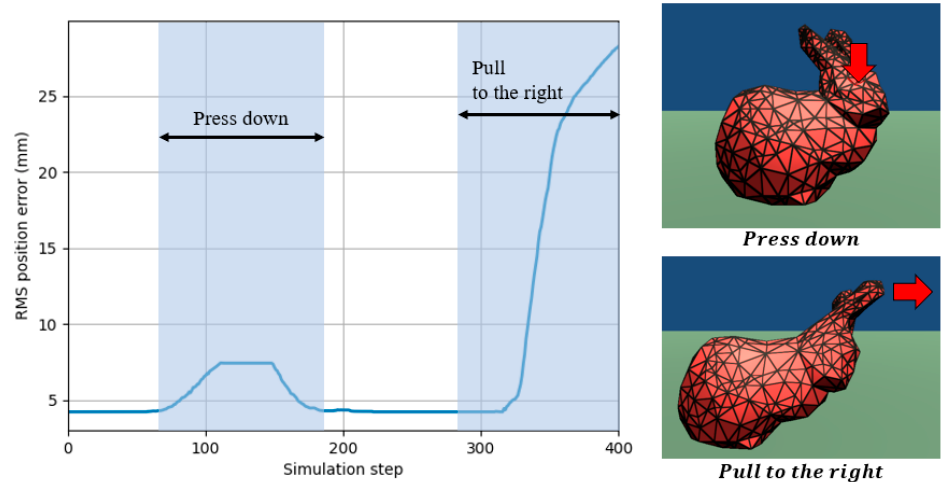
Figure 11. Root mean square position error of the Stanford Bunny model over simulation time steps.